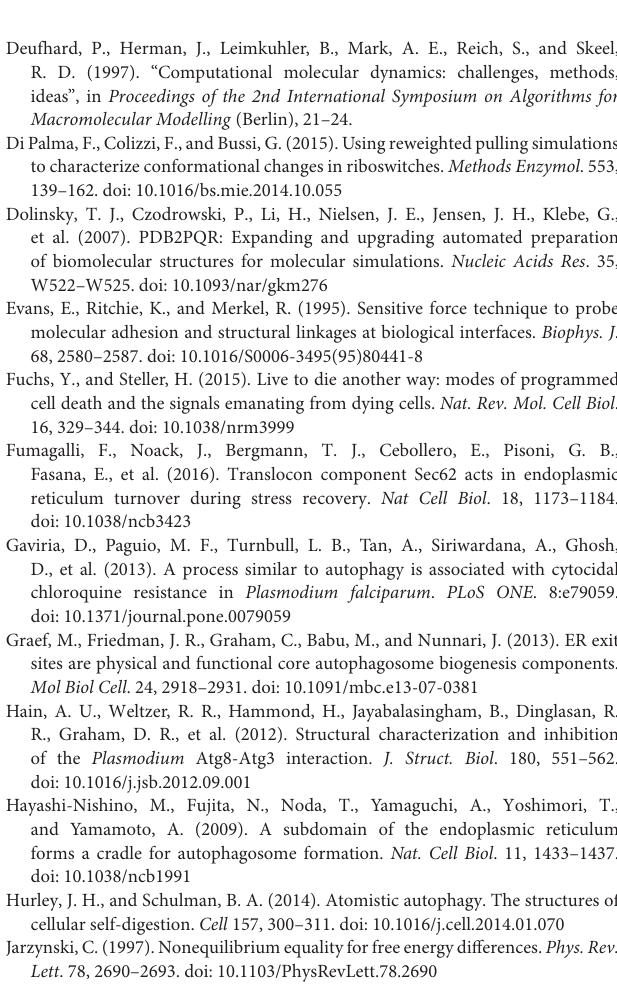
Figure S1 | Super-positioning of Pf Atg8-NDWLLP peptide complexes derived from (i) x-ray crystallography (green); (ii) GalaxyPepDock predicted peptide-protein complex (orange), and (iii) a stable conformation obtained from molecular dynamics simulations (blue).